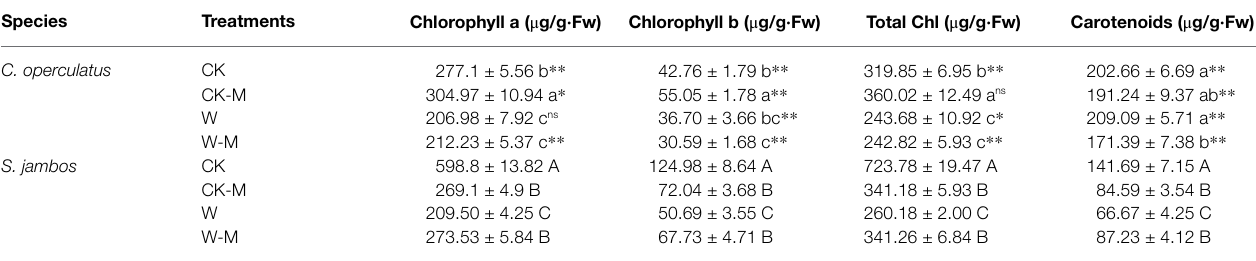
TABLE 2 | The variations of chlorophyll a, chlorophyll b, total chlorophyll and carotenoids in C. operculatus and S. jambos among different treatments. Species